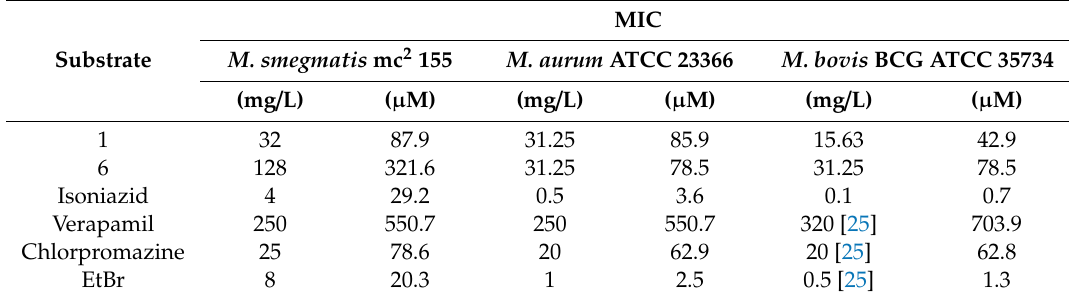
Table 2. MIC values of the substrates against M. smegmatis mc 2 155 detected via microbroth dilution method. Spot culture growth inhibition (SPOTi) methods applied for testing with the strains M. aurum and M. bovis